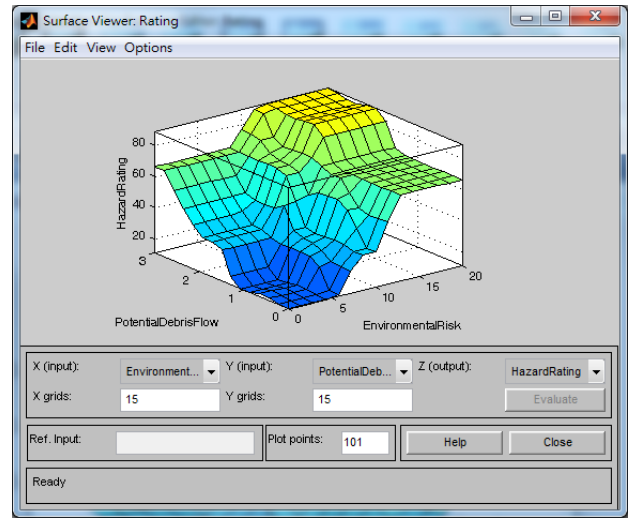
Figure 5. Operation result of fuzzy expert system.